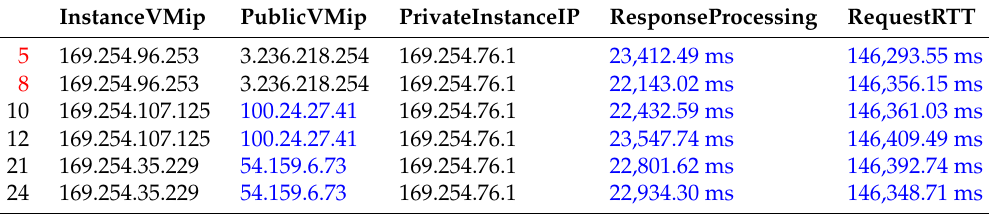
Table 9. Dataset Extract Re-Used